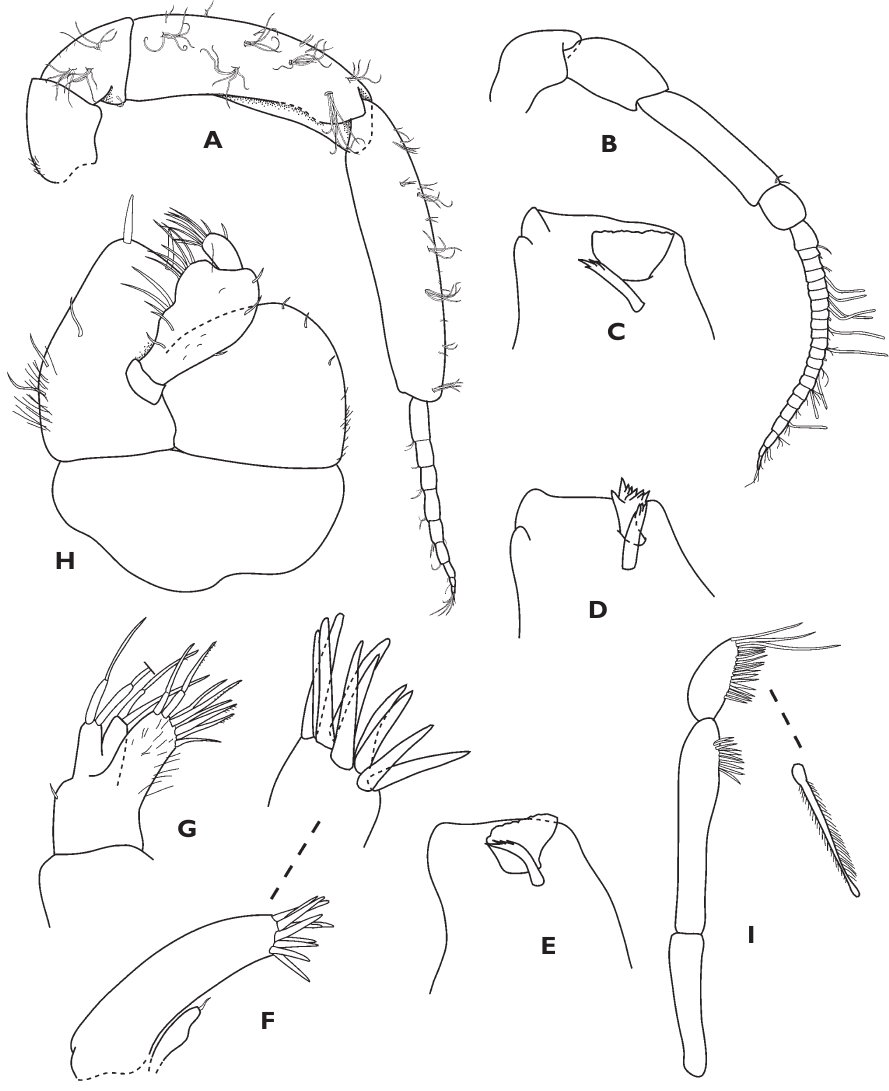
Figure 6. Sedorolis simplex sp. n. Paratype ♂ 4.8 mm, Is.6001, except C, D, ♀ ovig 5.3 mm, Is. 6001. A antenna B antennule C left mandible D right mandible E left mandible F maxillule G maxilla H maxilliped I mandible